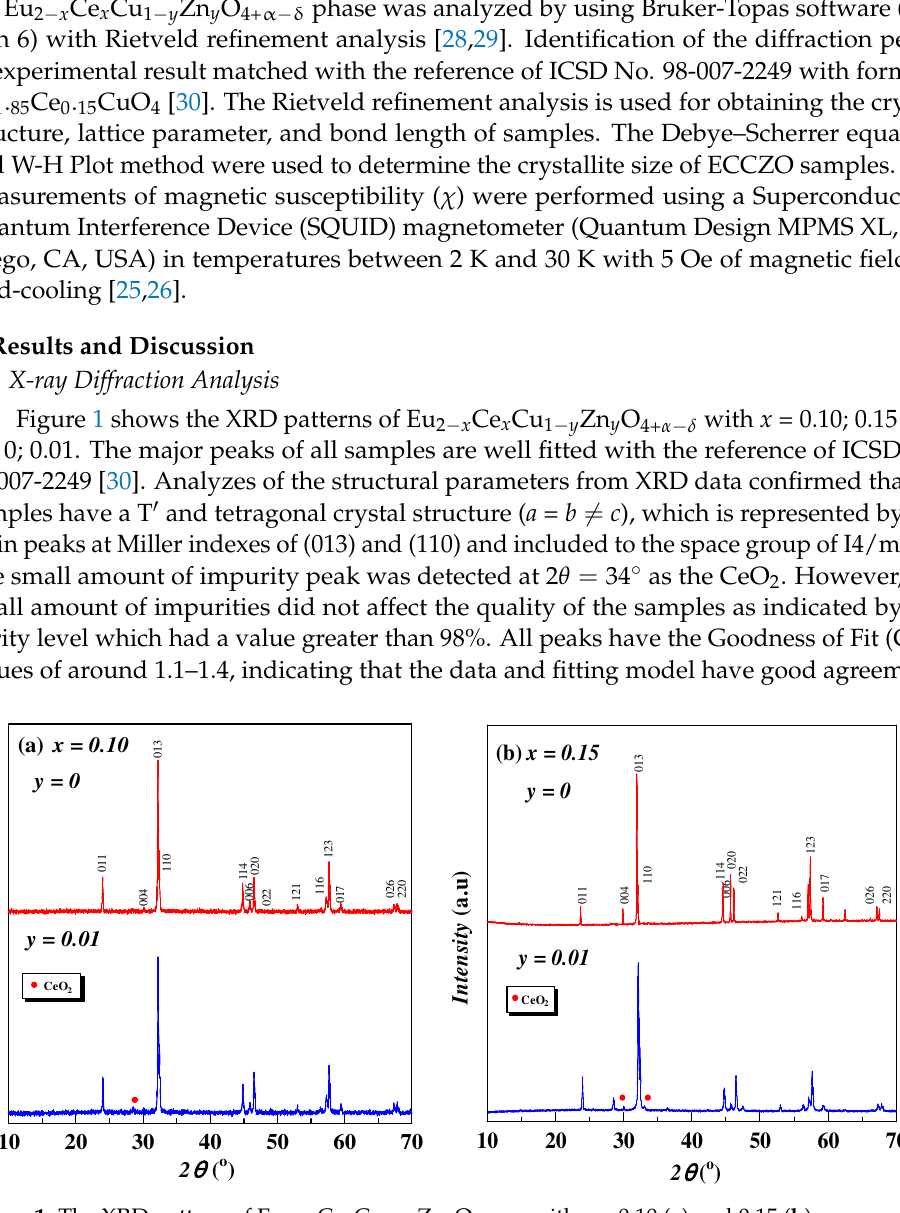
Figure 2. Crystal structure of Eu 2− x Ce x Cu 1− y Zn y O 4+ α − δ . The crystallite size ( D ) of samples can be estimated using the Debye–Scherrer for- mula and W-H plot method. The Debye–Scherrer formula is shown in Equation (1), and W-H plot method is shown in Equation (2) [31,32]. (cid:10) =